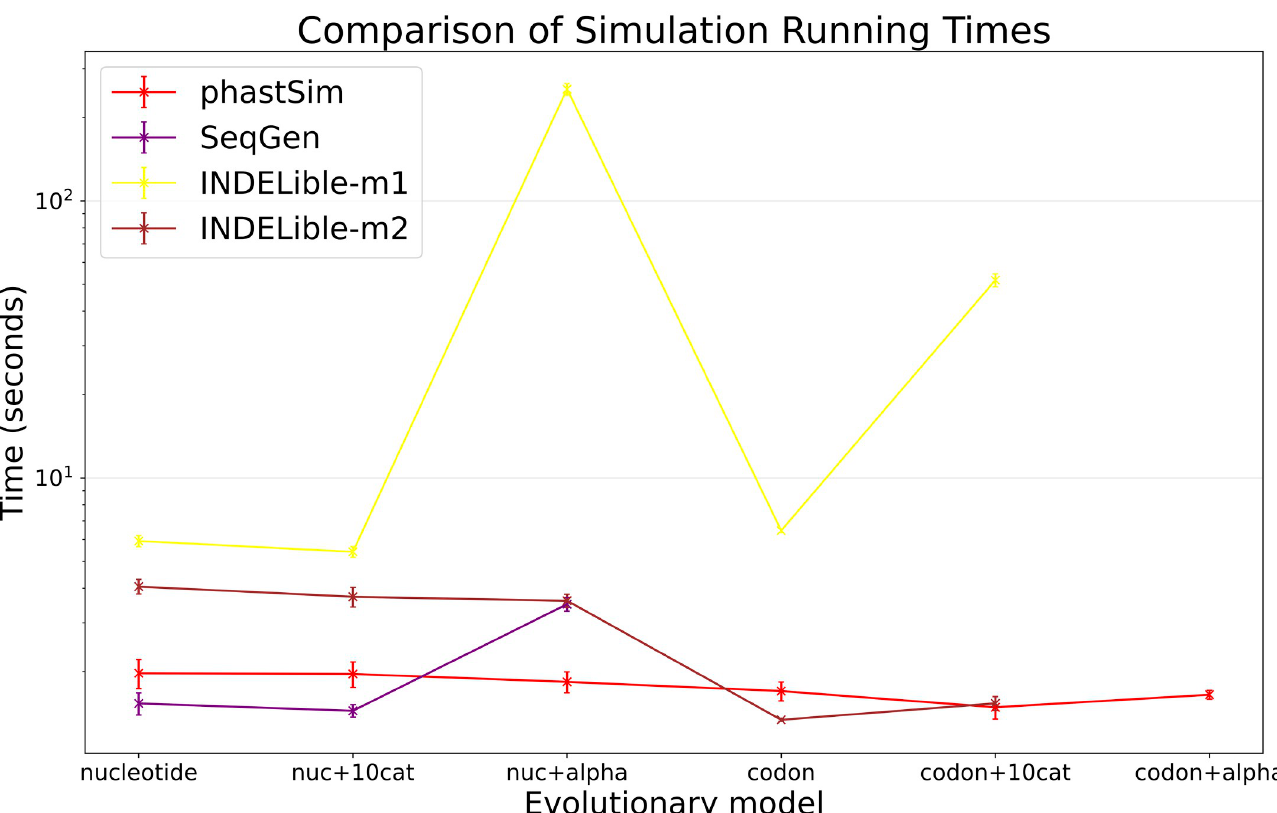
Fig 5. Comparison of running times of different simulators in a SARS-CoV-2 scenario using different evolutionary models. On the Y axis we show the number of seconds it takes to perform simulations using different software. On the X axis is the model used for simulations: “nucleotide” is a nucleotide substitution model without variation; “nuc+10cat” is a nucleotide model with 10 rate categories; “nuc+alpha” is a nucleotide model with continuous variation in rate (each site has a distinct rate sampled from a Gamma distribution); “codon” represents a codon substitution model; “codon+10cat” represents a codon substitution model with 10 categories for ω ; “codon+alpha” is a codon model with continuous rate variation in mutation rate and in ω (only allowed in phastSim). Each value represents ten replicates. Seq-Gen does not allow codon models. Colors are as in Fig 3. Here we used alignments of 1000 tips.